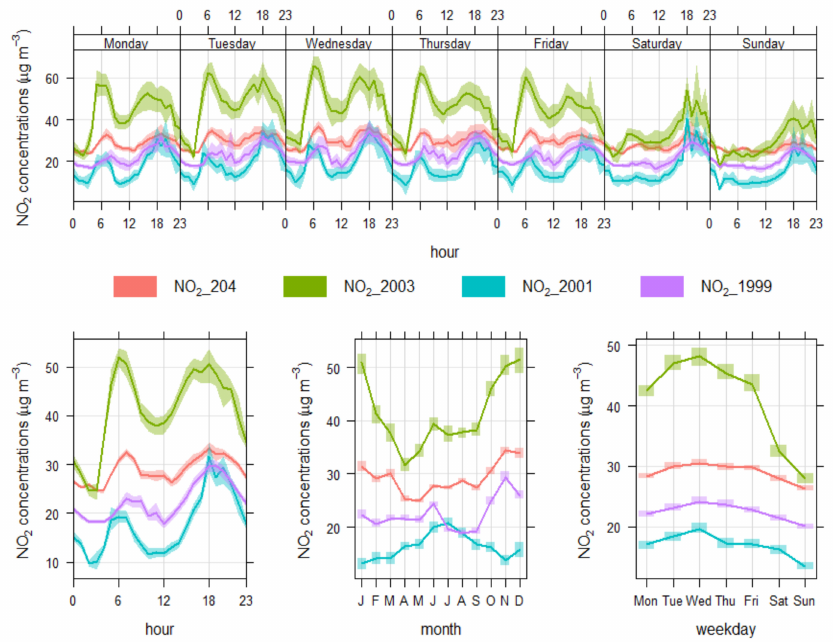
Figure 12. Time variation plots of NO 2 concentrations ( µ g/m 3 ) measured by AQMesh